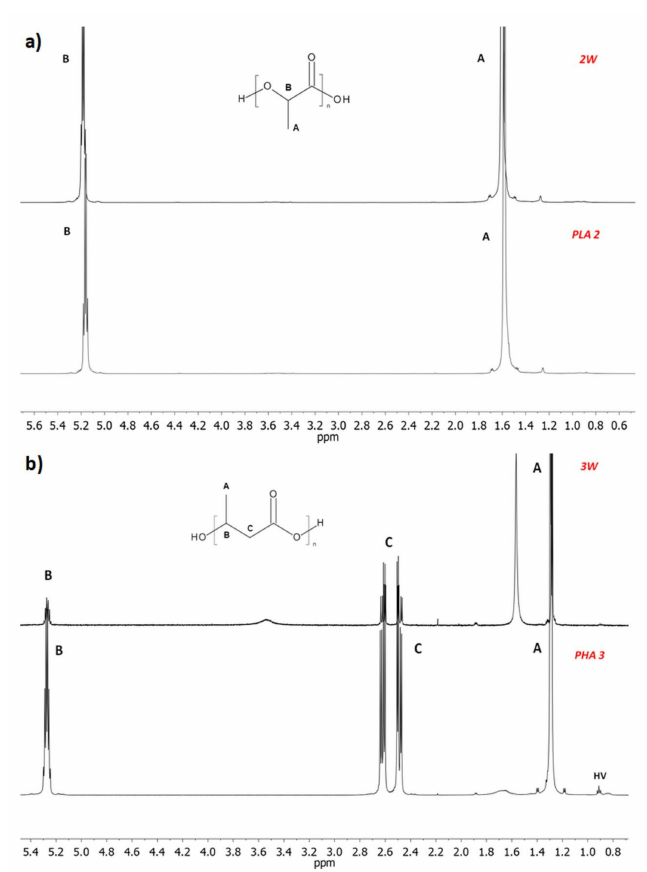
Figure 1. 1 H-NMR spectra of samples ( a ) PLA 2 and ( b ) PHA 3 and of their welds (2W and 3W).